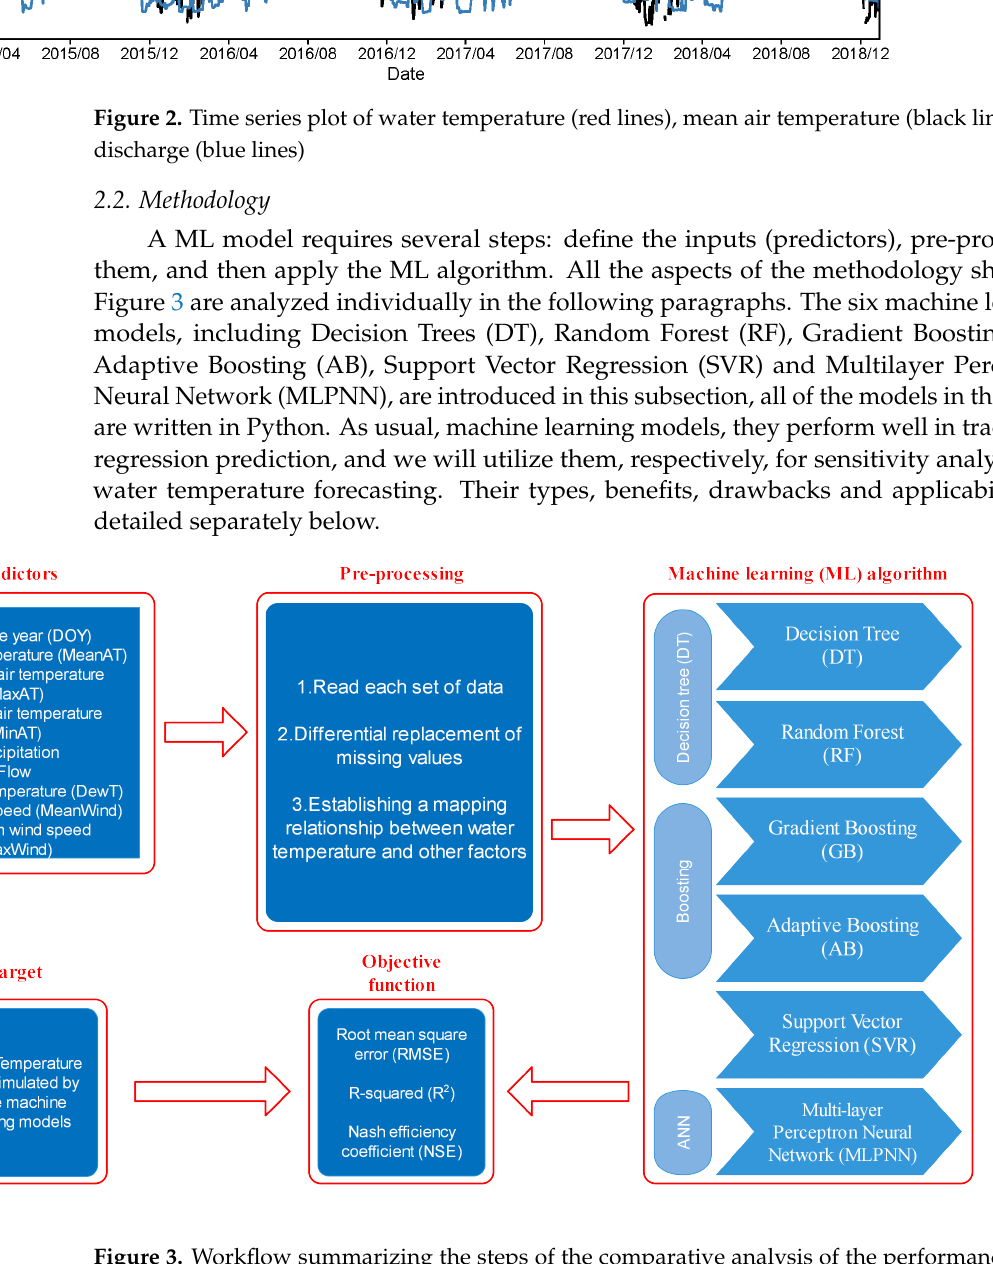
Figure 3. Workflow summarizing the steps of the comparative analysis of the performance of the different ML